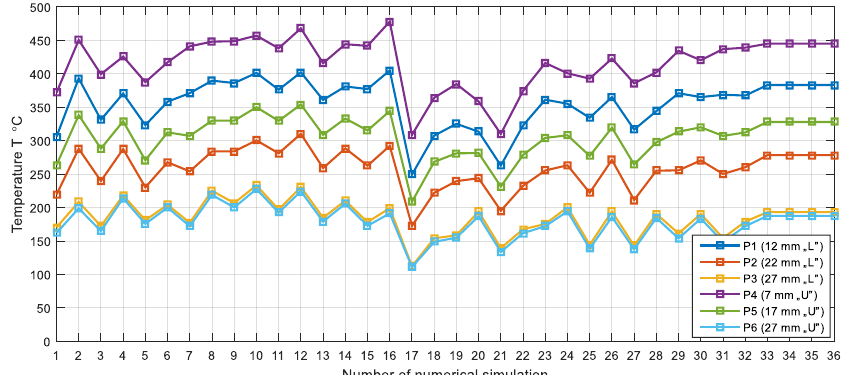
Figure 16. The obtained welding temperature values for all numerical simulations.